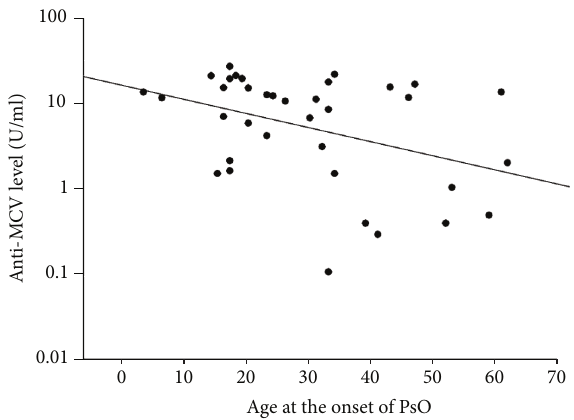
Figure 6: Anti-MCV levels of PsA and PsO patients with and without nail psoriasis. The plots represent the antibody levels of PsA and PsO patients with and without nail psoriasis. The horizontal linesindicatethemeanlevelsofanti-MCVs.Thedifferencesbetween the groups were not significant ( 𝑃 = 0.305